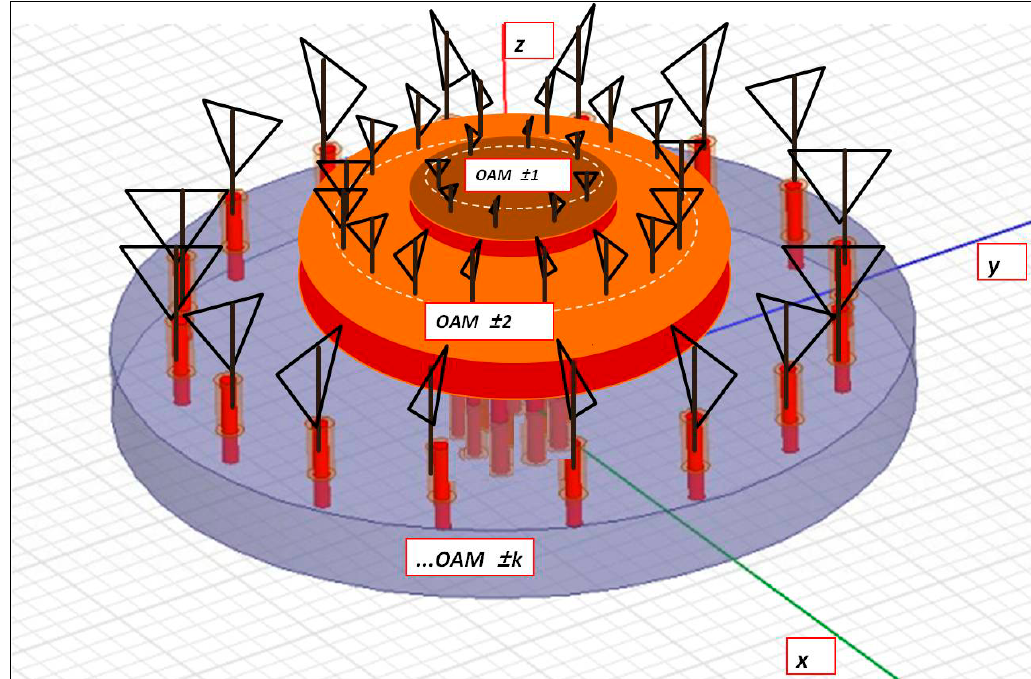
Figure 5. Example of stacked circular transmitting arrays for OAM multiplexing, after [11].